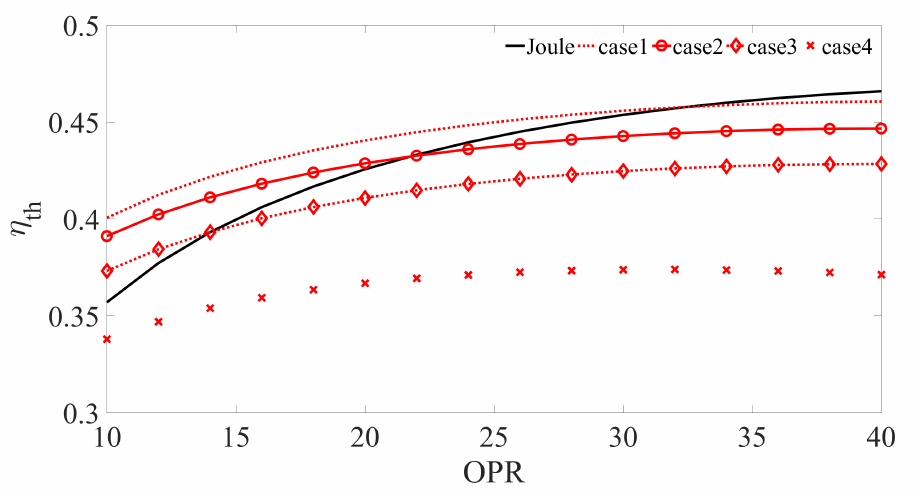
Figure 7. Cycle thermal efficiency as a function of compressor pressure ratio for the Joule cycle and the four versions of the Humphrey cycle presented in Table 3. TIT: 1300 ◦